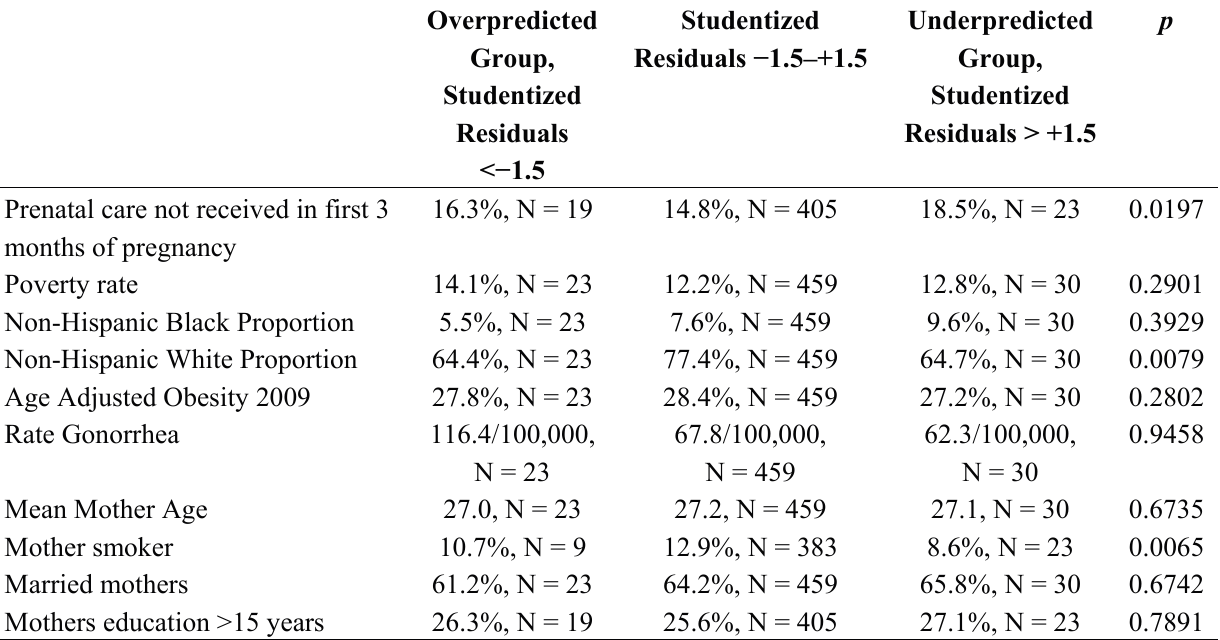
Table 3. Median values of selected predictor variables in county groups divided by studentized